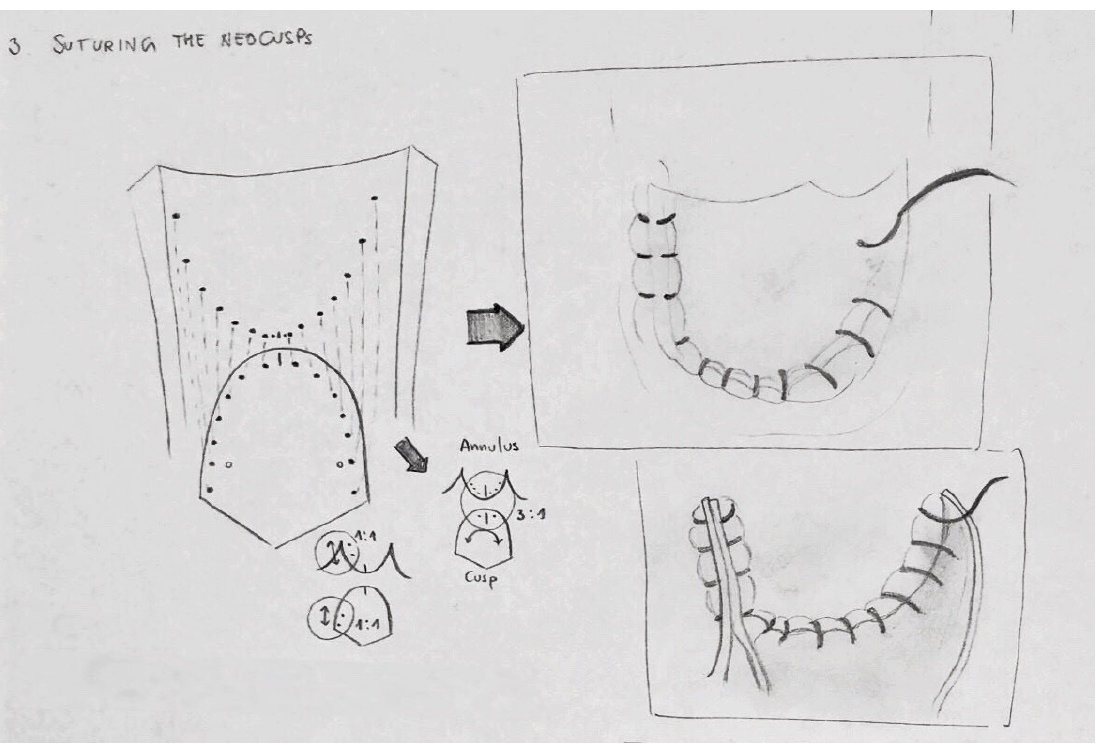
Fig. 3 – Stitch distribution and annular-neocusp